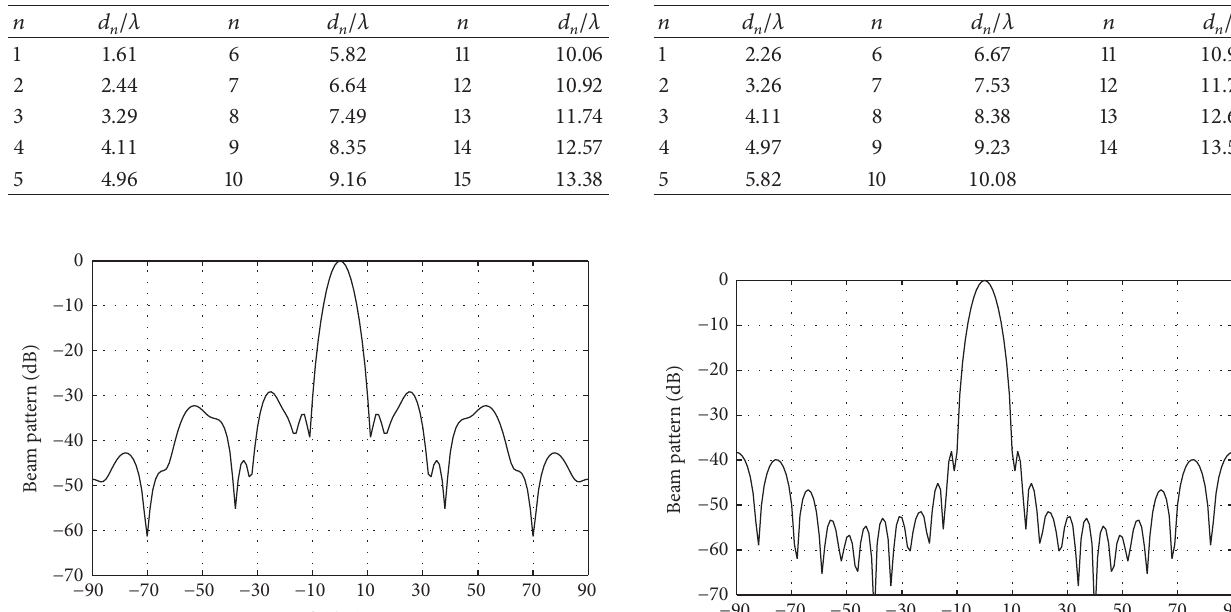
Table 3: Locations for the postprocessing design example.